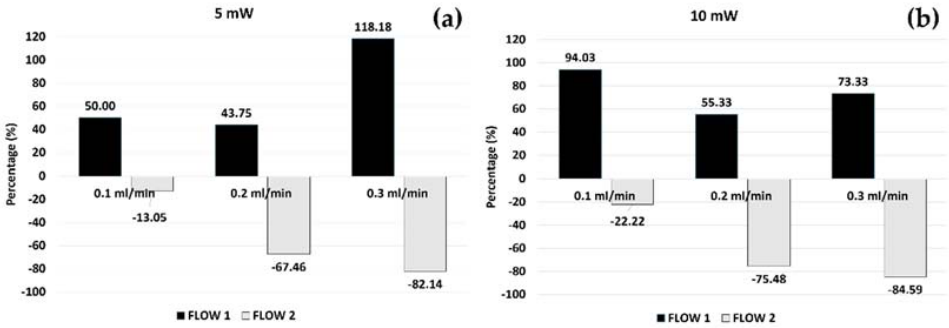
Figure 12. The percentage of change ( ∆ %) of T period measured in the flow passage using the PDMS mofd and ZnO-PDMS mofd per experimental condition (EXP1 and EXP2) for ( a ) FLOW1 and ( b )